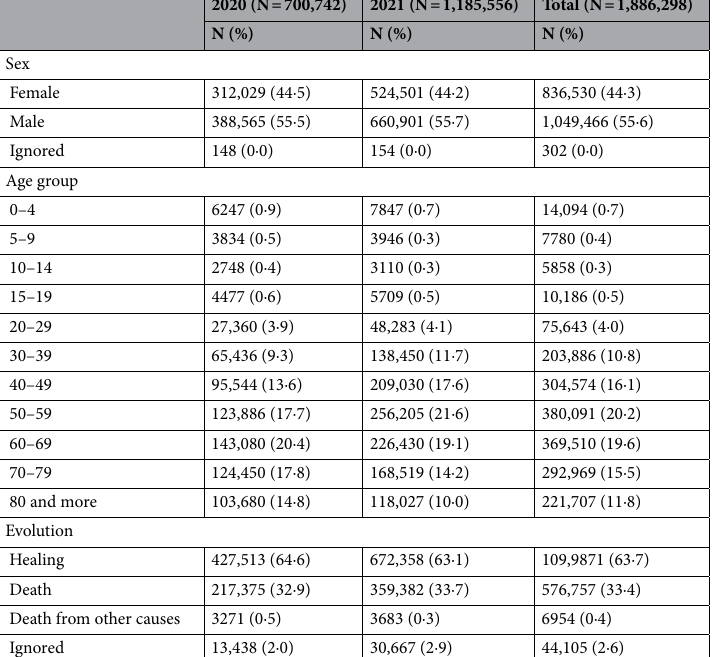
Table 1. Number of SARS cases, Brazil, 2020 and